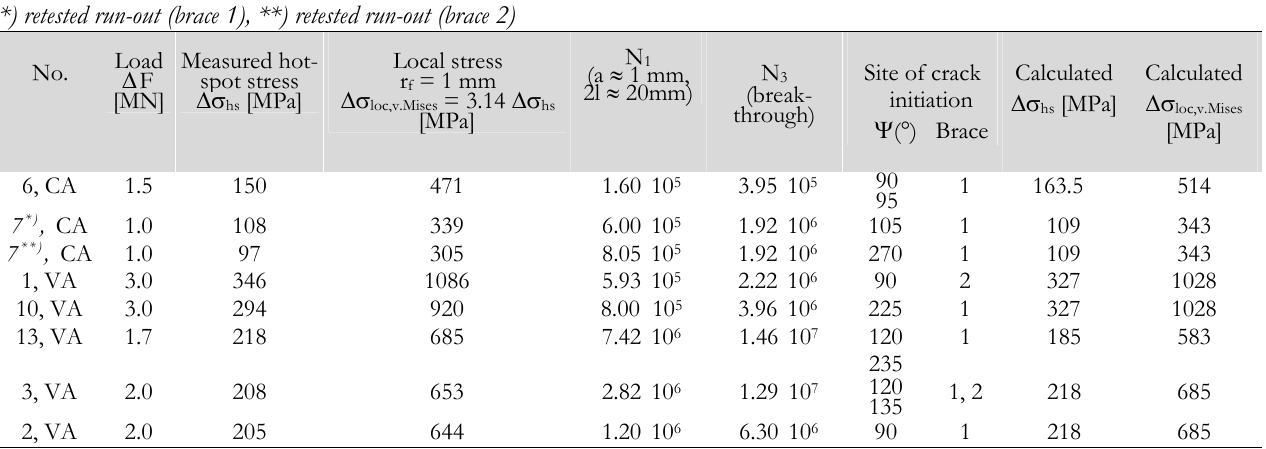
Table 2: Test and calculation results obtained with welded K-nodes.